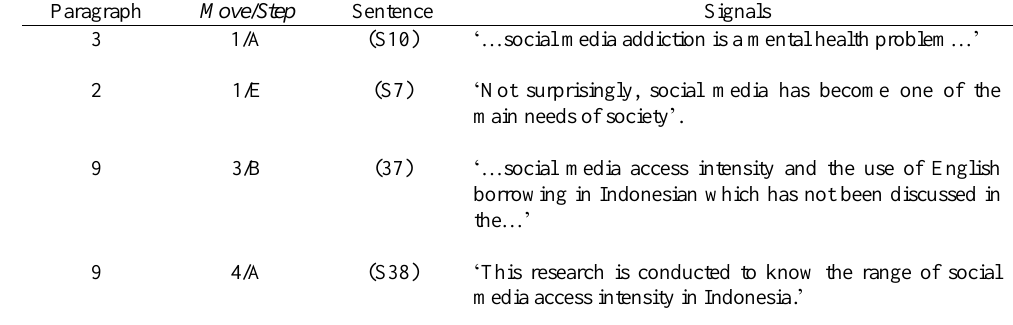
Move and Step in Research Article Introduction (RAI) in article 1.2 Research article